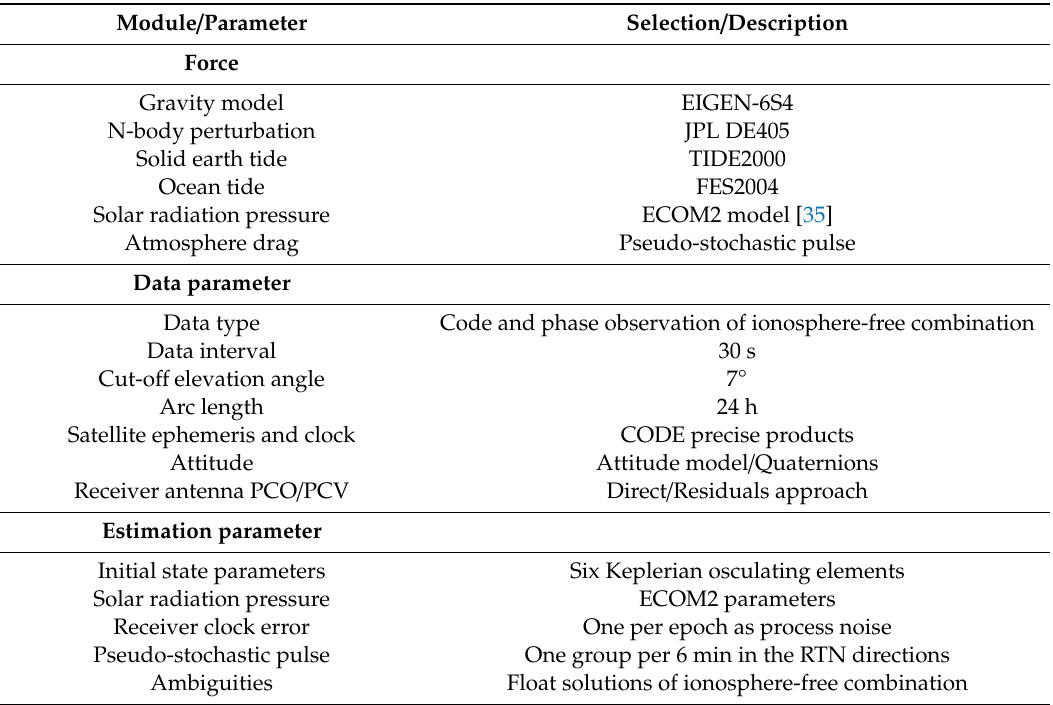
Table 1. Module / Parameter for Jason-3